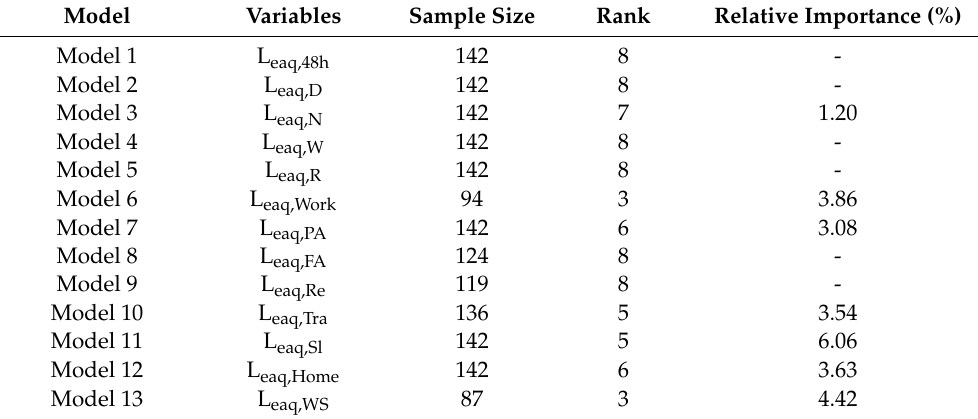
Table 3. Relative contributions of noise exposure variables on mental